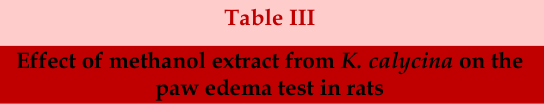
Effect of methanol extract from K. calycina on